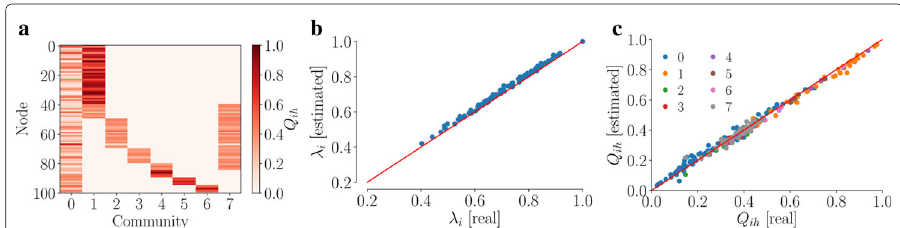
Fig. 10 Validation on a synthetic network with overlapping communities. In ( a ), matrix Q is illustrated (color intensity is proportional to the value of the entry). Estimations of the vector λ and of the matrix Q are shown in ( b ) and ( c ), respectively. Different colors in ( c ) indicate different